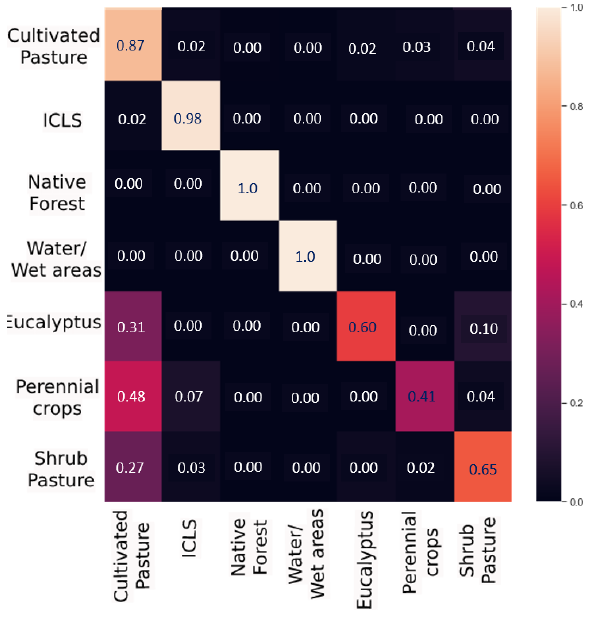
Figure 3. Confusion matrix(Recall values) for LSTM classifier (Entire Season).